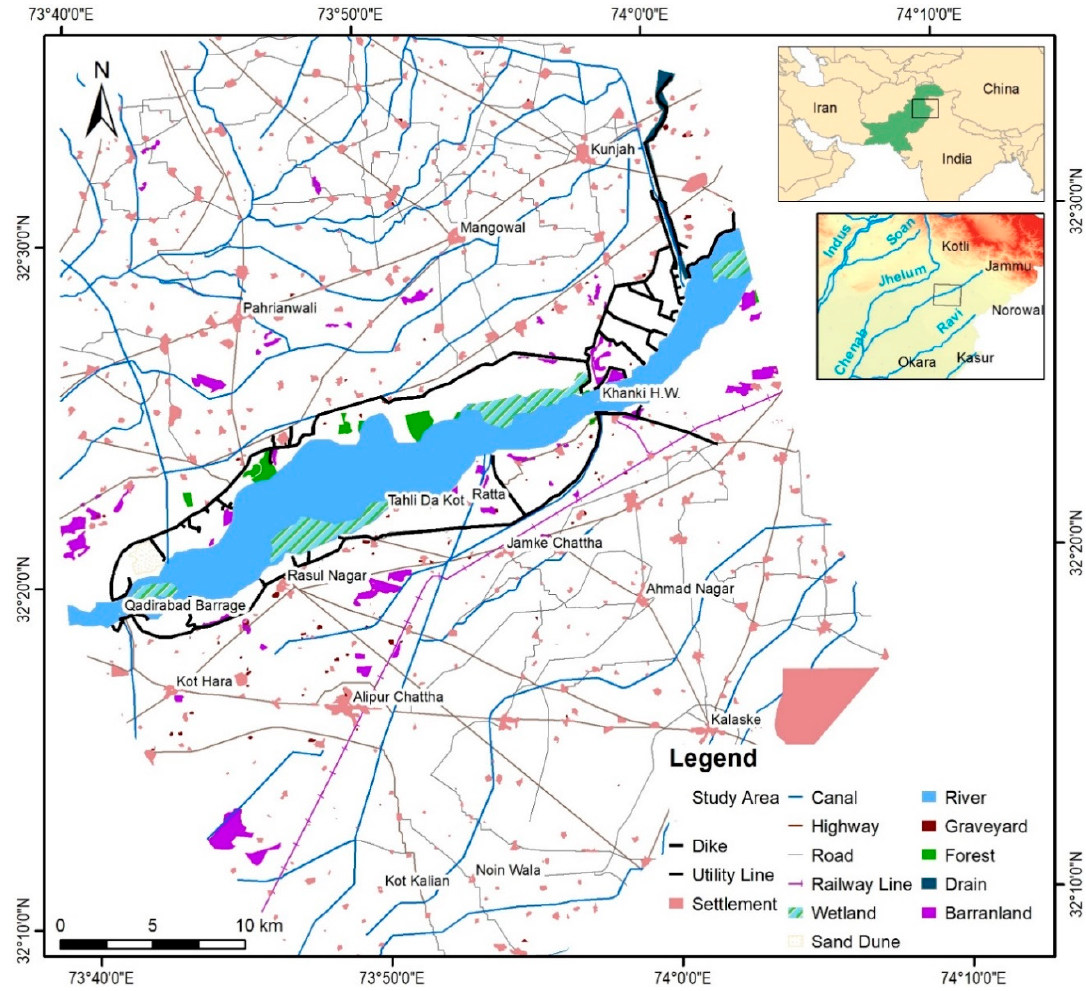
Figure 4. A 42-km-long floodplain reach study area starting upstream of the Khanki Headworks to Qadarabad Barrage.